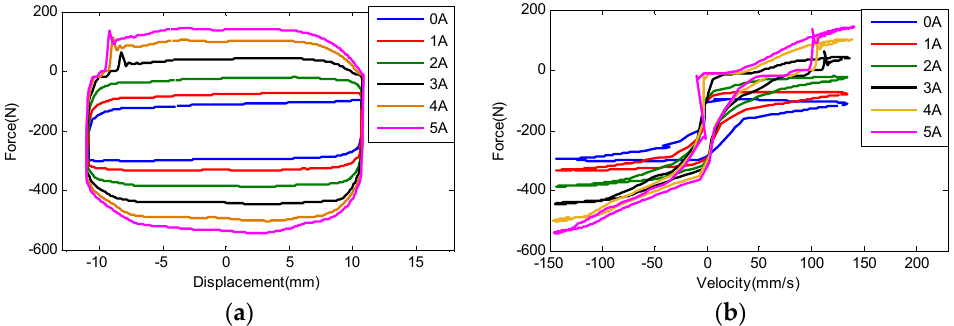
Figure 4. Damping characteristic diagrams of the MRF damper. ( a ) 10 mm–2 Hz displacement–force diagram; ( b ) 10 mm–2 Hz velocity–force characteristic diagram.